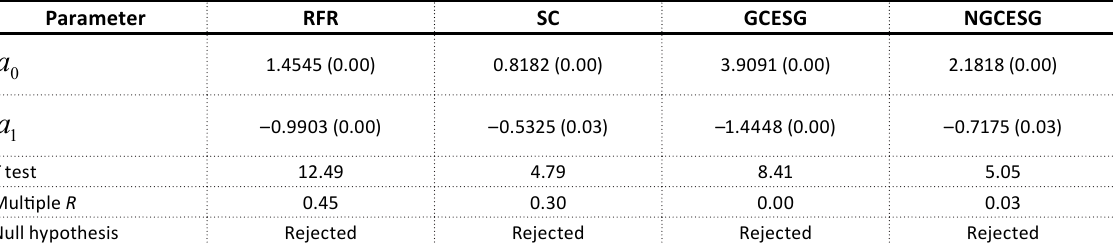
Rejected Rejected Rejected Note: * p -values are in